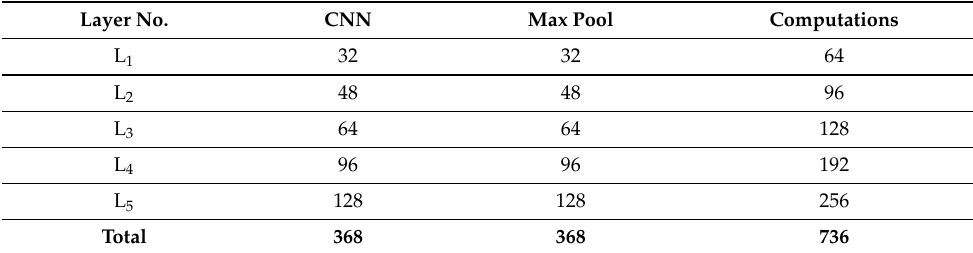
Table 1. Computational Complexity of Proposed Algorithm. Layer